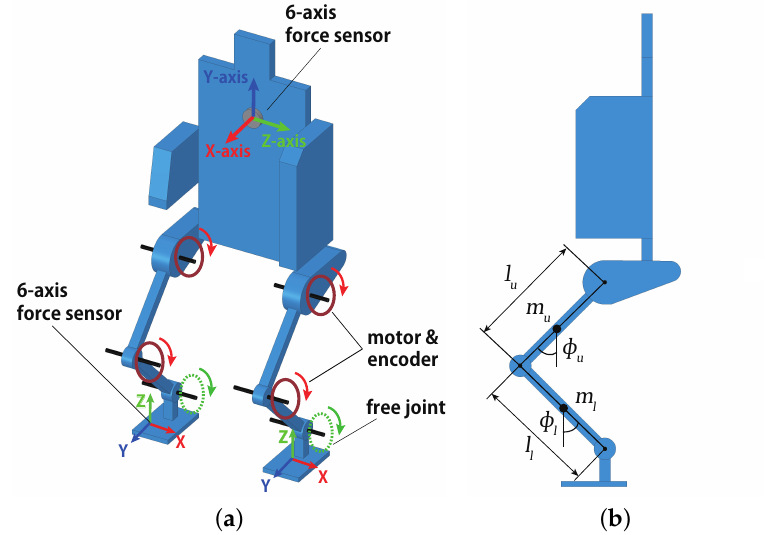
Figure 1. Configuration of powered exoskeleton. ( a ) Axes of force sensors and the degrees of freedom of the joints; ( b ) Side view and zero position of